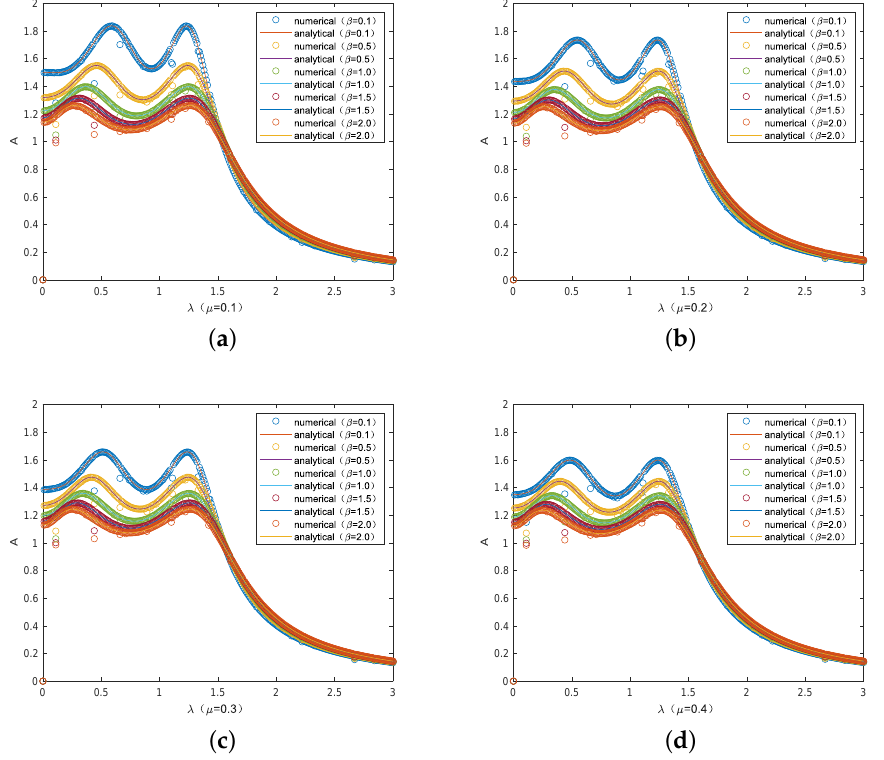
Figure 9. Comparison between the numerical solution and analytical solution when optimizing the single variable ν ( α 2 opt = α 2 b ): ( a ) µ = 0.1; ( b ) µ = 0.2; ( c ) µ = 0.3; ( d ) µ =